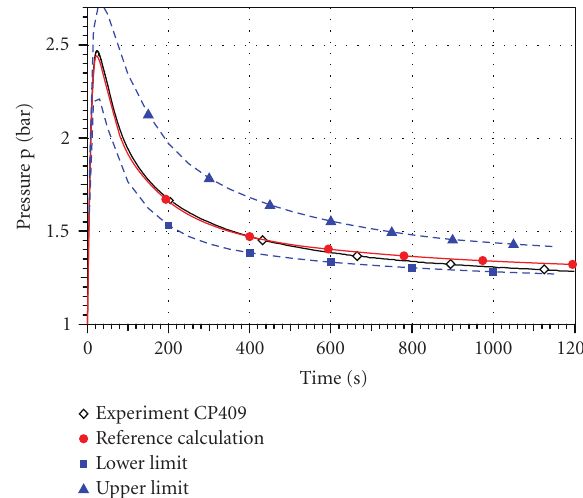
Figure 6: 95% / 95% uncertainty interval, reference calculation and experimental values for pressure in the upper part of the contain- ment versus time.